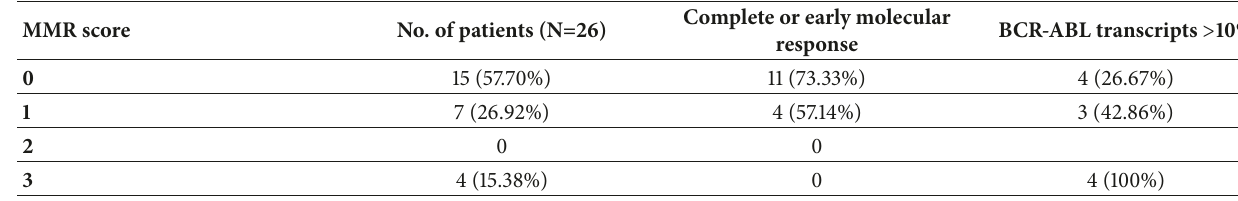
Table 5: Correlation of marrow morphological response (MMR) score with molecular response. MMR